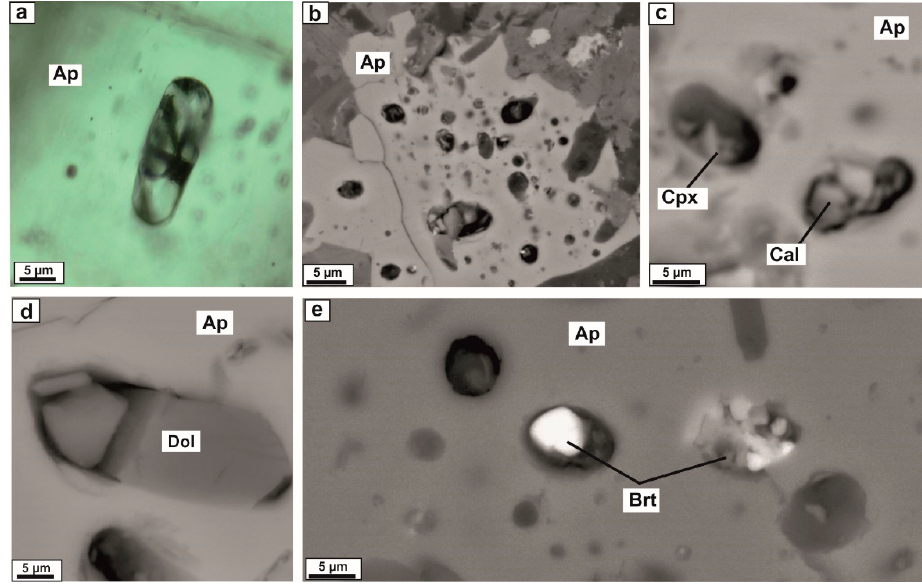
Figure 12. Crystal-fluid inclusions in the apatite of the damtjernites of the Terina complex: ( a ) microphotograph of the crystal-fluid inclusion; ( b–e ) BSE photos of the opened inclusions containing crystalline phases of clinopyroxene (Cpx), calcite (Cal), dolomite (Dol), and barite